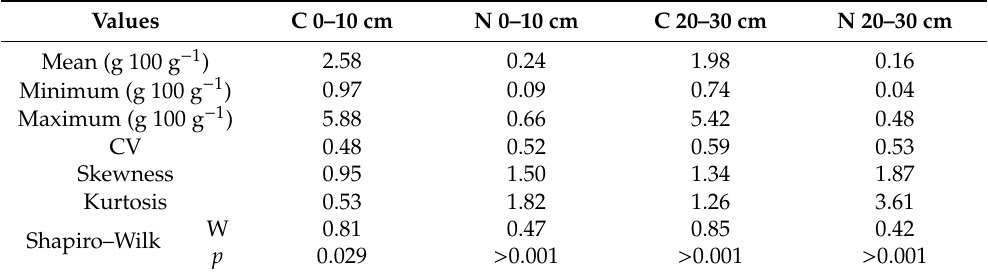
Table 2. Descriptive statistics and Shapiro–Wilk normality test for input